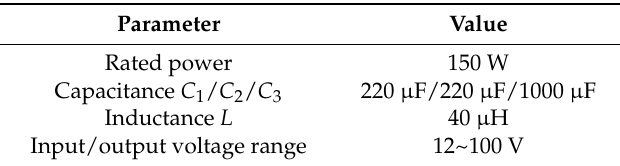
Table 2. Main parameters of the